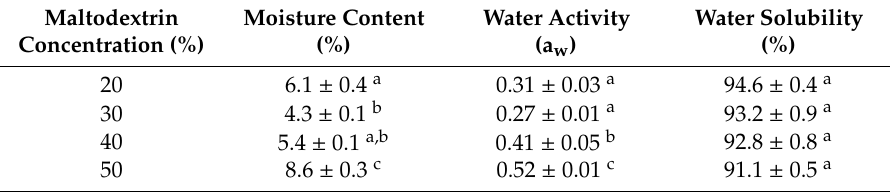
Table 3. Moisture content, water activity, and water solubility of Andean blueberry juice freeze-dried powders obtained with di ff erent concentrations of